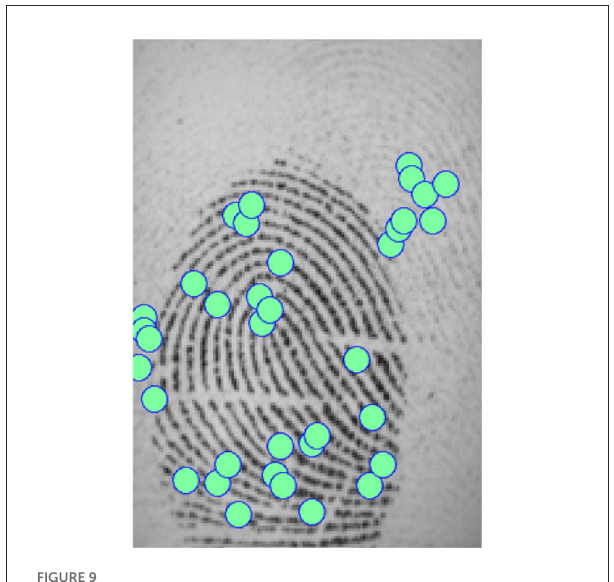
FIGURE9 Example of fingerprint with minutiae